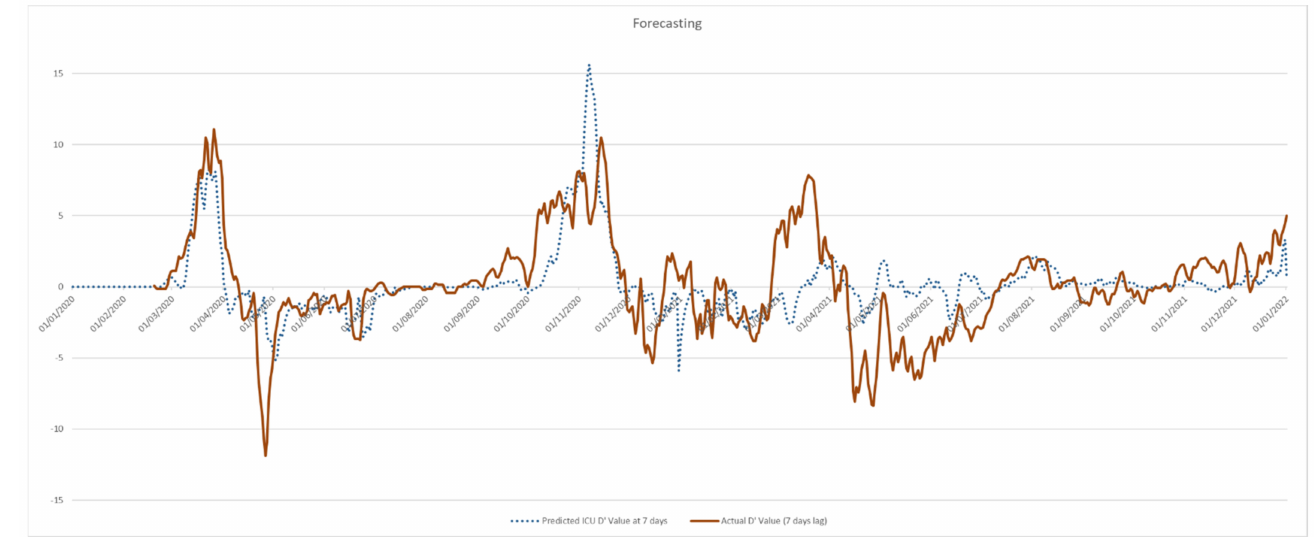
Figure 6. Predicted vs. expected values of first order derivative of 7-days ICU admissions in Lazio Region, Italy,